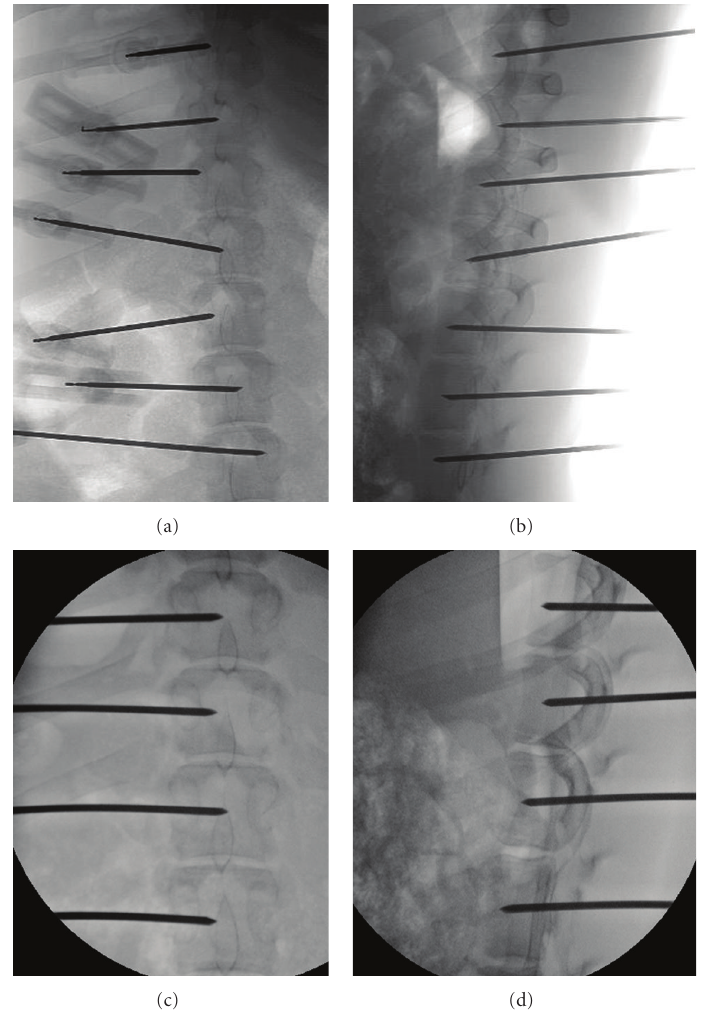
Figure 2: Plain radiographs for evaluation. (a) Landmark method, frontal view. (b) Landmark method, lateral view. (c) ISOP method, frontal view. (d) ISOP method, lateral view.